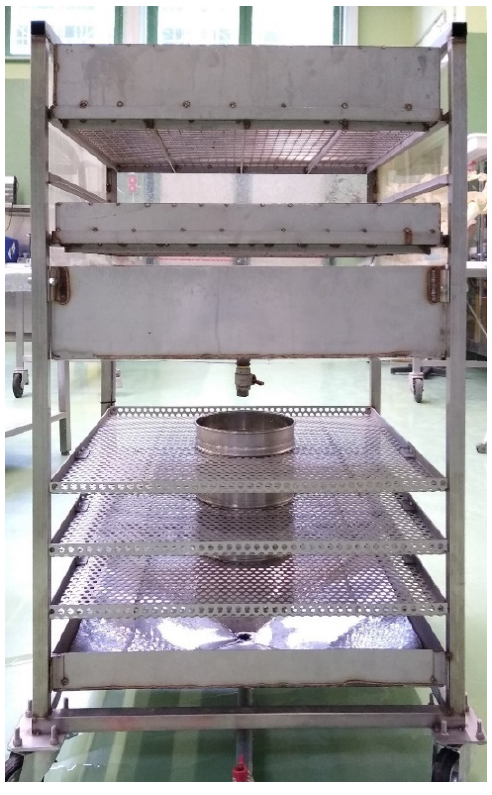
Figure 1. The multi-sieves tool is composed of the support and insertable sieves. The meshes dimensions selected to tested in the sieves sequence and the motivation for which they were chosen, are reported in Table 2, as the possible investigation that can be performed on the content collected in the sieves. In Table 3 are shown the meshes sequences tested and the problems and solutions identified for each